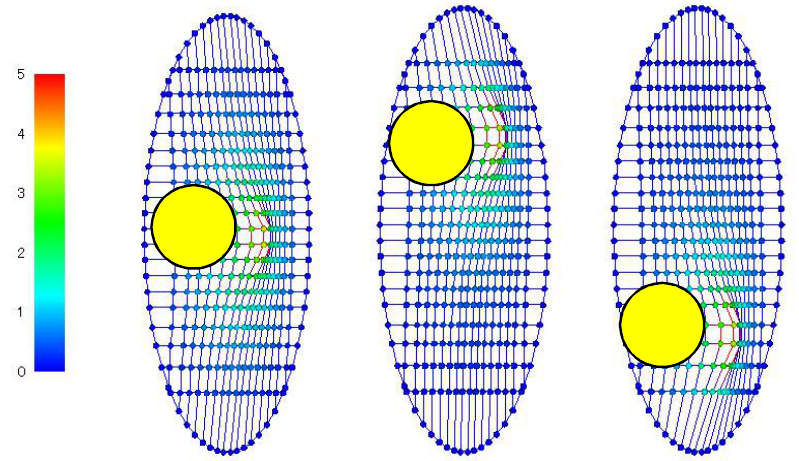
Figure 11. Simulated results of deformation of string bed in tennis racket (force=100 N, display 10 times displacement in out-of-plane direction).